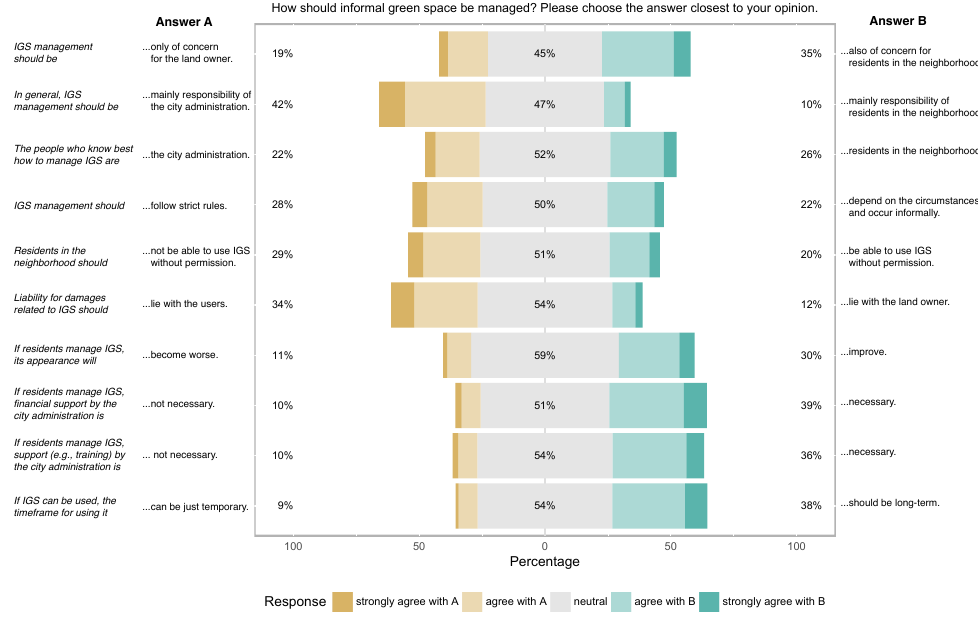
Figure 8. Respondents’ opinion on approaches to IGS